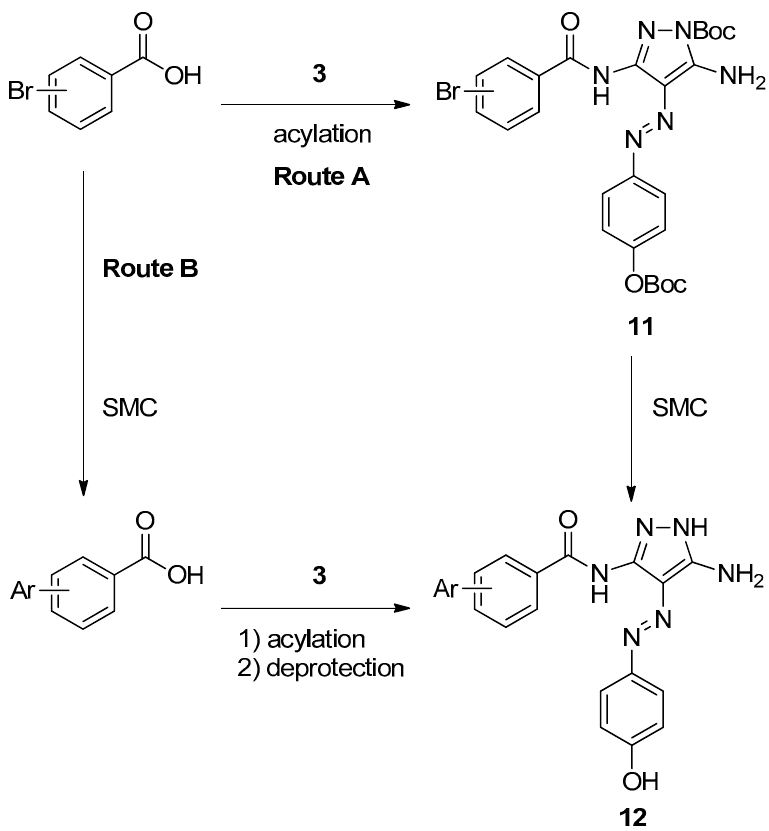
Scheme 1. Possible synthetic routes leading to pyrazoles 12 .